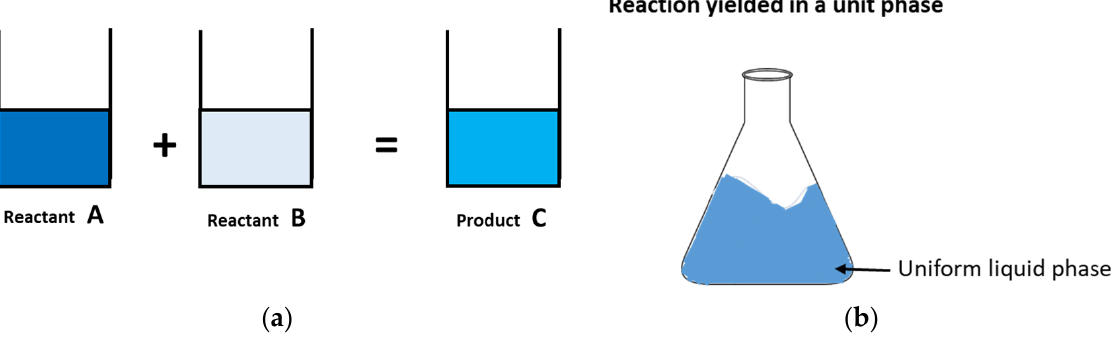
Figure 6. ( a ) Reaction of two different liquids (A and B), and ( b ) catalytic reaction in phase.